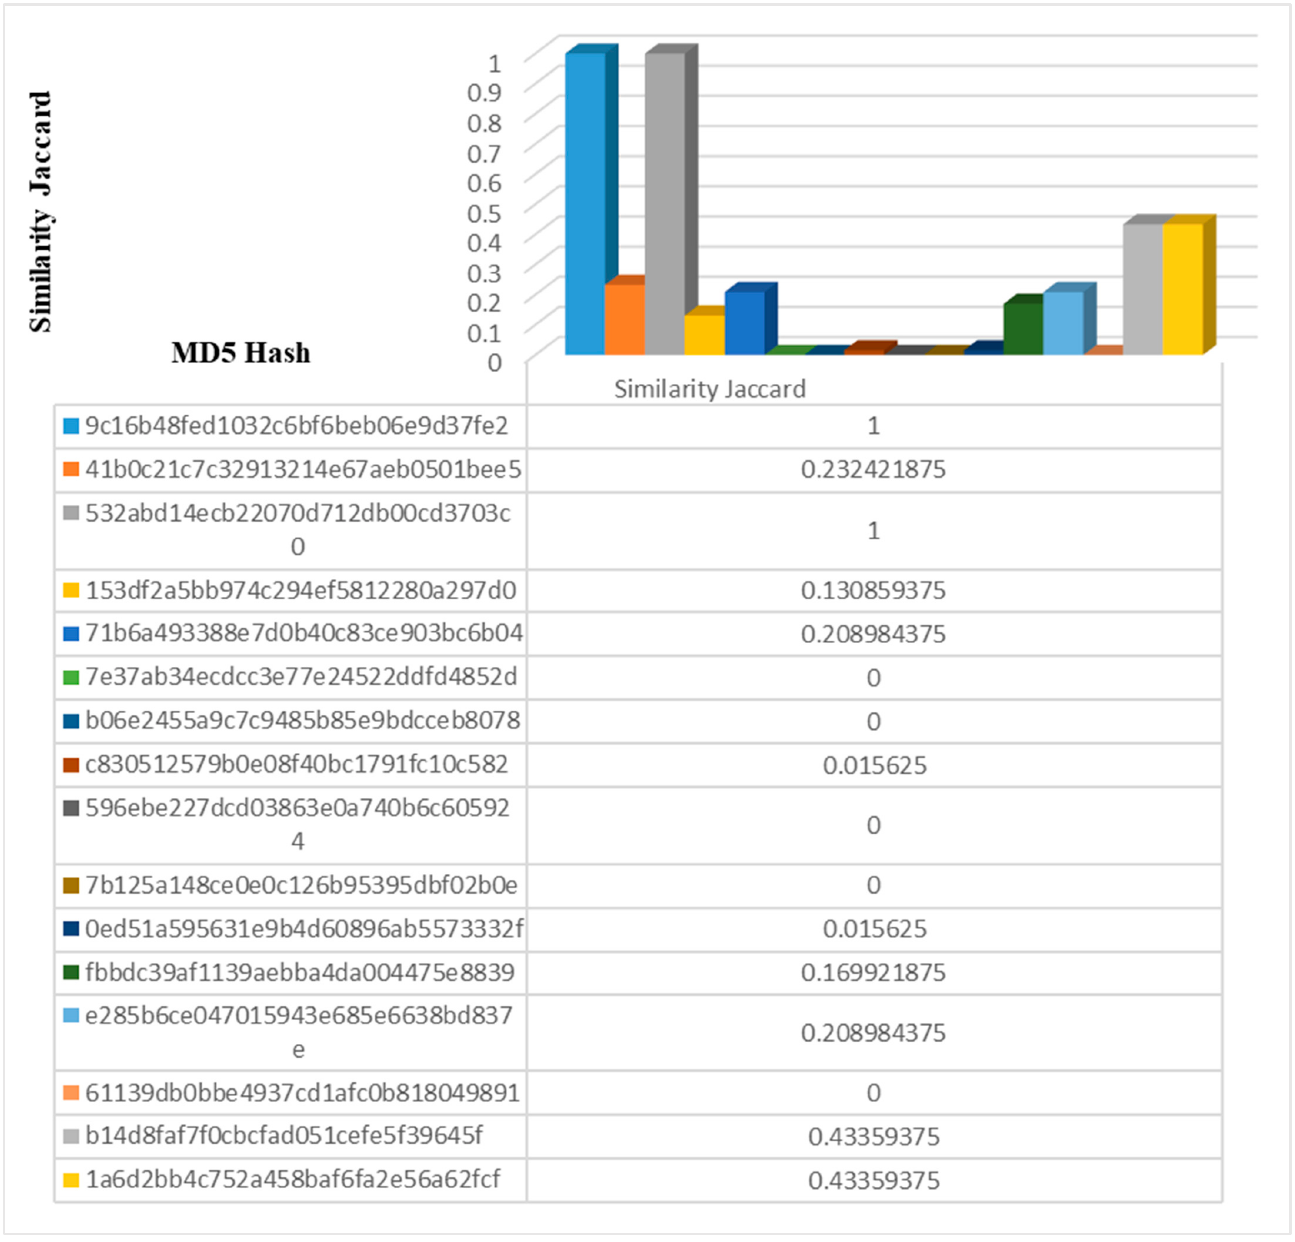
Figure 20. Import address similarity of ransomware samples.